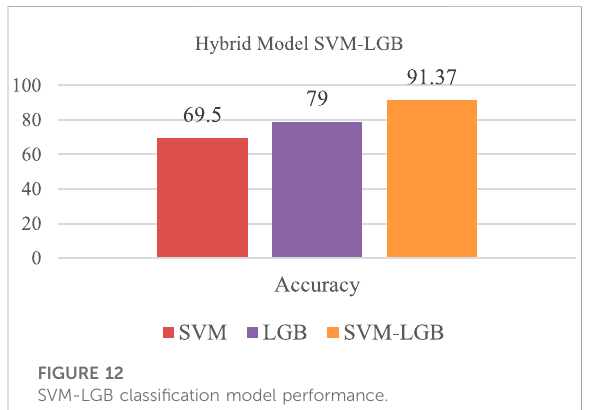
FIGURE 14 SVM-HGBC Classi fi cation Model performance.